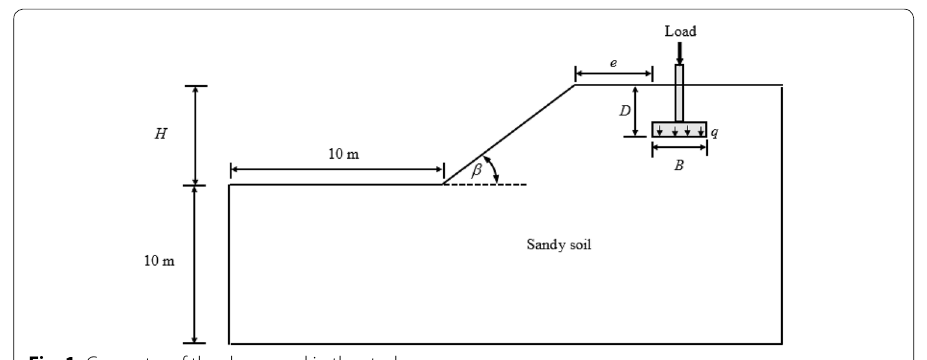
Fig. 1 Geometry of the slope used in the